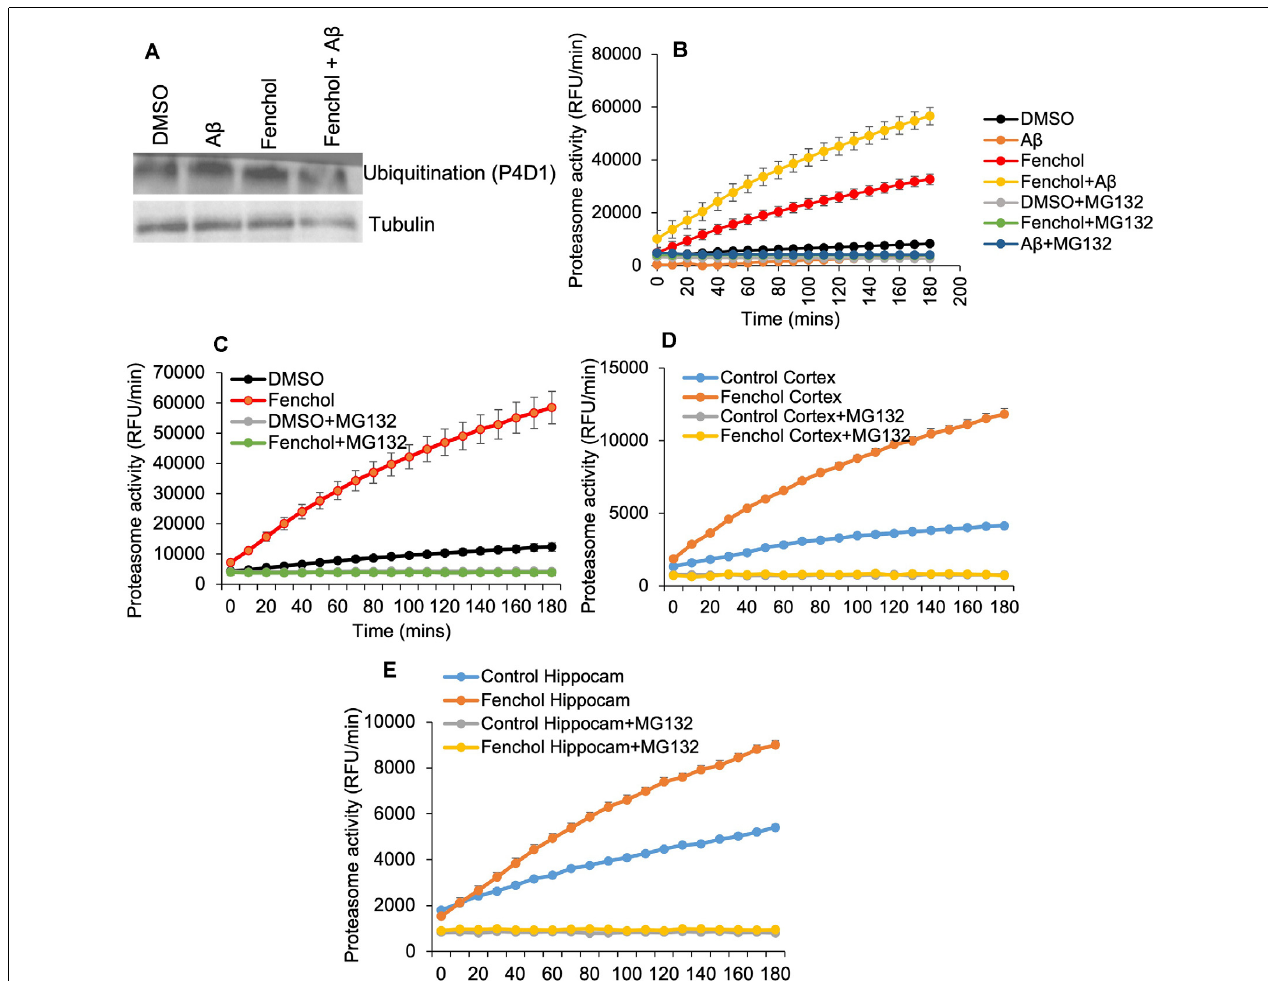
FIGURE 5 | Fenchol treatment increased proteasome activity, without impacting protein ubiquitination. (A) Total protein ubiquitination in Western blots with anti-P4D1 antibody was not impacted by Fenchol treatment. (B,C) Proteasome activity was significantly increased in Fenchol treated SK-N-SH cells (B) and C. elegans (C) . Proteasome activity was higher in Fenchol treated SK-N-SH cells that were also treated with A β . Interestingly, Fenchol treatment also increased proteasome activity in APP/PS1 mice cortex (D) and hippocampus (E) regions. Data are the mean and standard error of means from three independent experiments done in